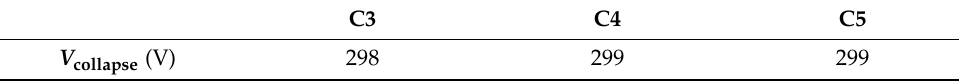
Table 3. The collapse voltages of C3–C5.